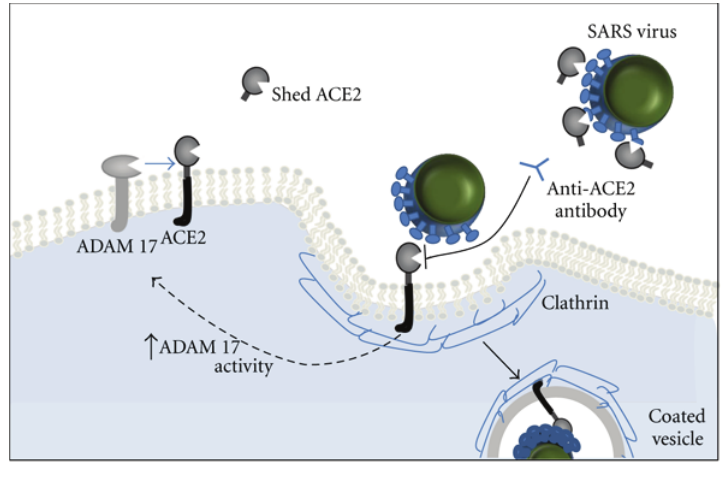
Figure 3: ACE2 acts as the host cell receptor for SARS-CoV, by binding to the spike protein on the viral capsid. Binding to ACE2 stimulates clathrin-dependent endocytosis of both ACE2 and the SARS-CoV, which is essential for viral infection. Binding of the spike protein to ACE2 induces ADAM 17 activity, thereby reducing the amount of ACE2 expressed on the cell surface. Treatment with soluble ACE-2 or anti-ACE-2 antibodies disrupts the interaction between virus and